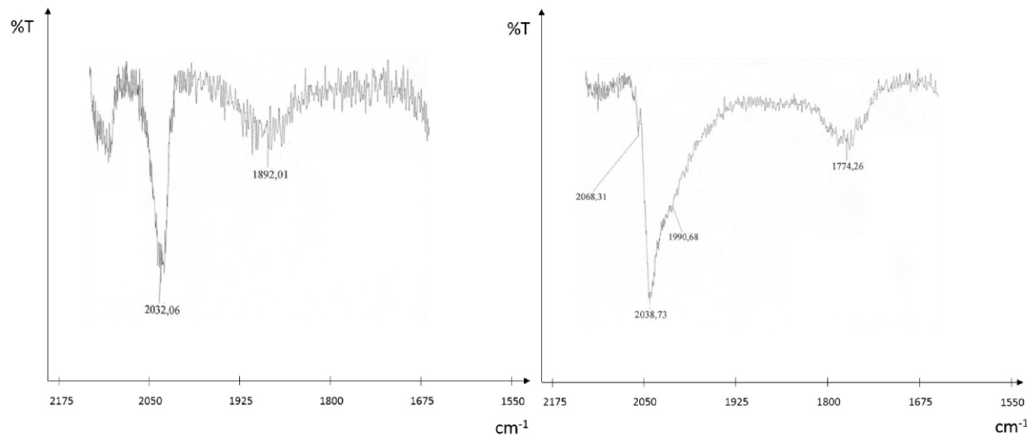
Figure 3. Solid-state IR spectra of the bare (left) and Rh-deposited (right) ZOm support.